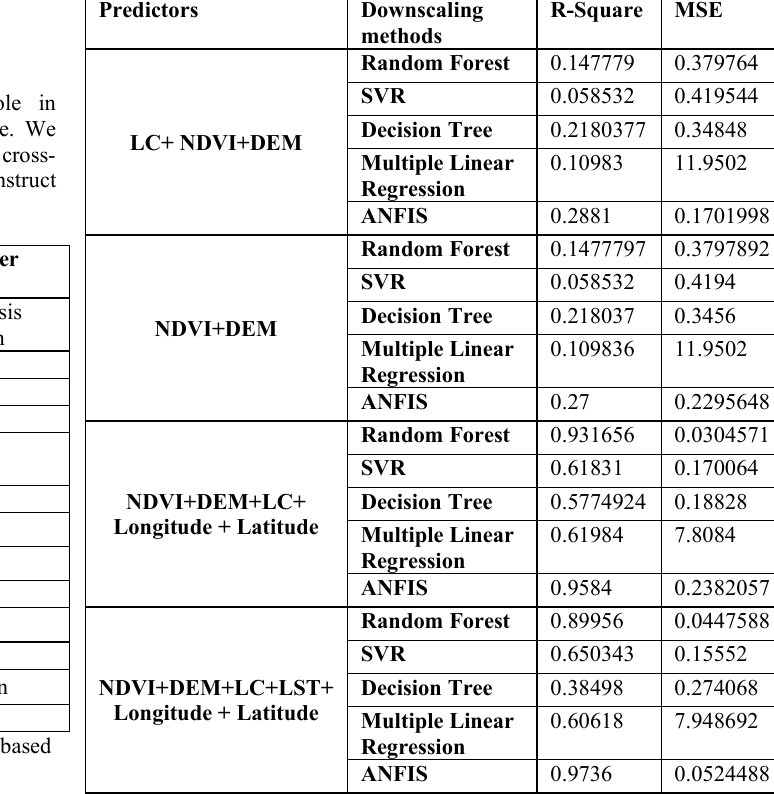
Table.3 Downscaling model validation results for year